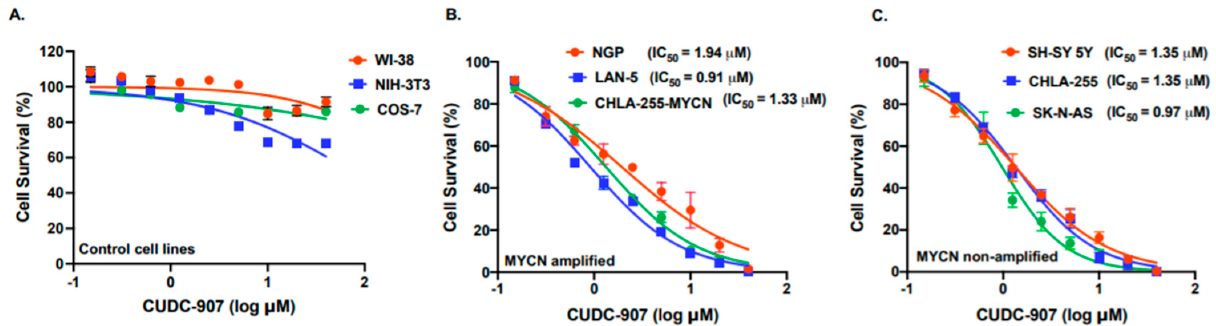
Figure 2. CUDC-907 inhibits NB proliferation. In vitro cytotoxicity assays in response to CUDC-907 Figure 2. CUDC ‐ 907 inhibits NB proliferation. In vitro cytotoxicity assays in response to CUDC ‐ 907 using fibroblast cell lines and human NB cell lines. ( A ) WI-38, NIH-3T3, and COS-7 fibroblast cell using fibroblast cell lines and human NB cell lines. ( A ) WI ‐ 38, NIH ‐ 3T3, and COS ‐ 7 fibroblast cell lines. ( B ) NGP, LAN ‐ 5, and CHLA ‐ 255 ‐ MYCN as MYCN ‐ amplified NB cell lines. ( C ) SH ‐ SY ‐ 5Y, SK ‐ lines. ( B ) NGP, LAN-5, and CHLA-255-MYCN as MYCN -amplified NB cell lines. ( C ) SH-SY-5Y, SK- N ‐ AS, and CHLA ‐ 255 as MYCN non ‐ amplified NB cell lines. The nonlinear variable slope regression N-AS, and CHLA-255 as MYCN non-amplified NB cell lines. The nonlinear variable slope regression method was used to determine IC values for individual NB cell lines. 50 method was used to determine IC 50 values for individual NB cell